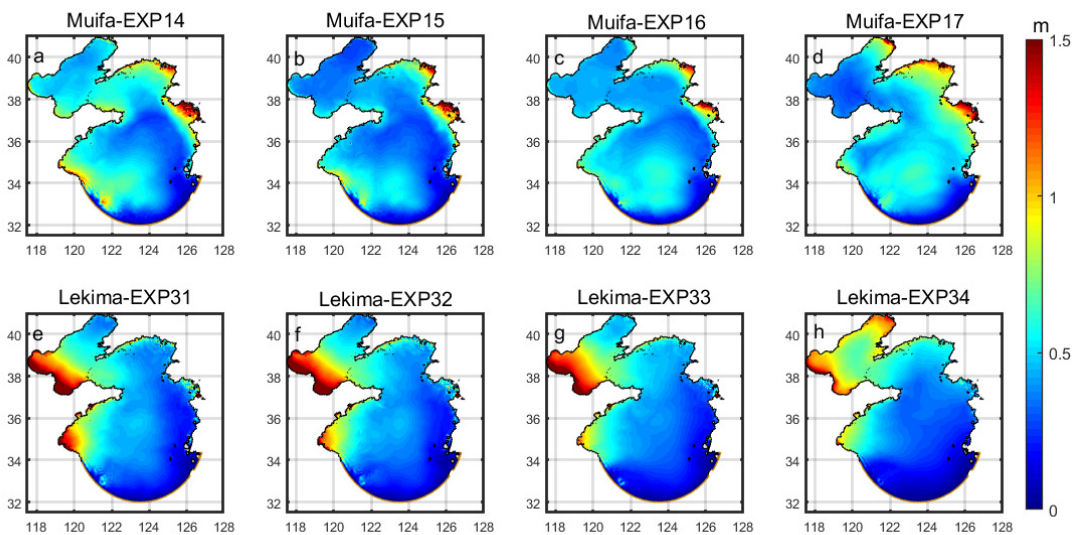
Figure 17. Spatial distribution of the storm surge when the translation speed was ( a ) 7.5 km/h, ( b ) 15 km/h, ( c ) 30 km/h, and ( d ) 60 km/h based on Typhoon Muifa and ( e ) 7.5 km/h, ( f ) 15 km/h, ( g ) 30 km/h, and ( h ) 60 km/h based on Typhoon Lekima. In the case of Typhoon Lekima, a faster typhoon translation speed was associated with a